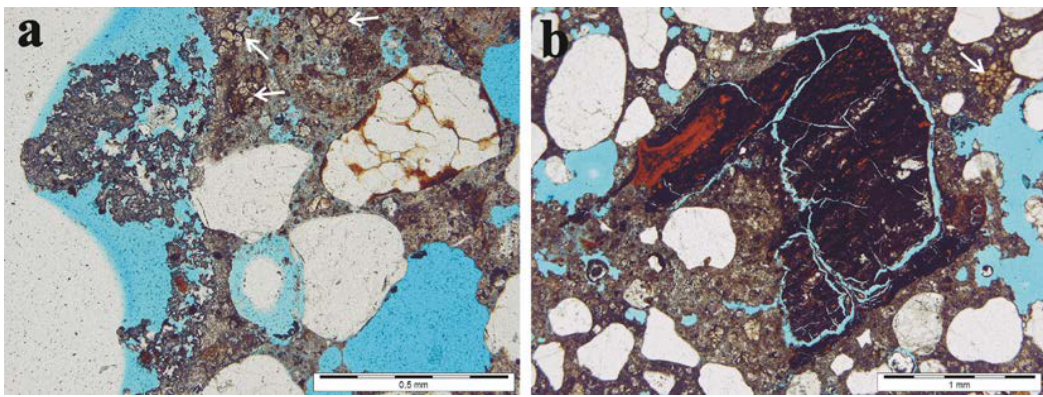
Figure 8. Microphotographs of the cement mortar, sample KD-M–3 taken from the exposed foundations: ( a ) gypsum crust on the surface and cement clinker clusters (marked with the arrow); ( b ) relics of charcoal used as a fuel for the cement burning and residual cement grains (arrow) (plane polarized light). Their chemical composition is variable; except, aggregates mostly composed of Si, Ca and O,